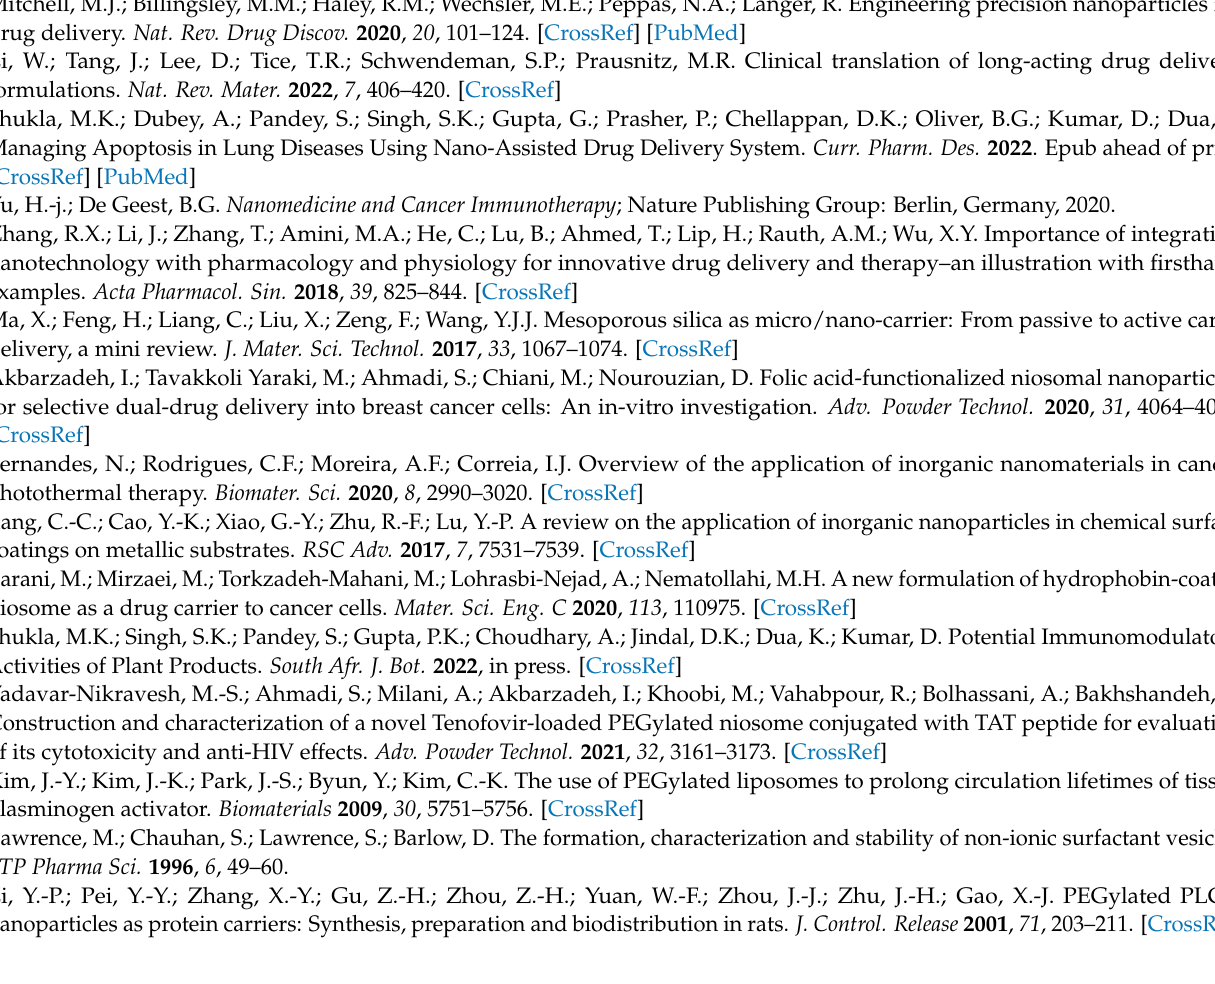
Figure S2: Stability data at different temperatures; Table S1: Different levels of independent variables used by Central Composite design; Table S2: Two types of categorical variables used by Central Composite design, Table S3: The primers used in